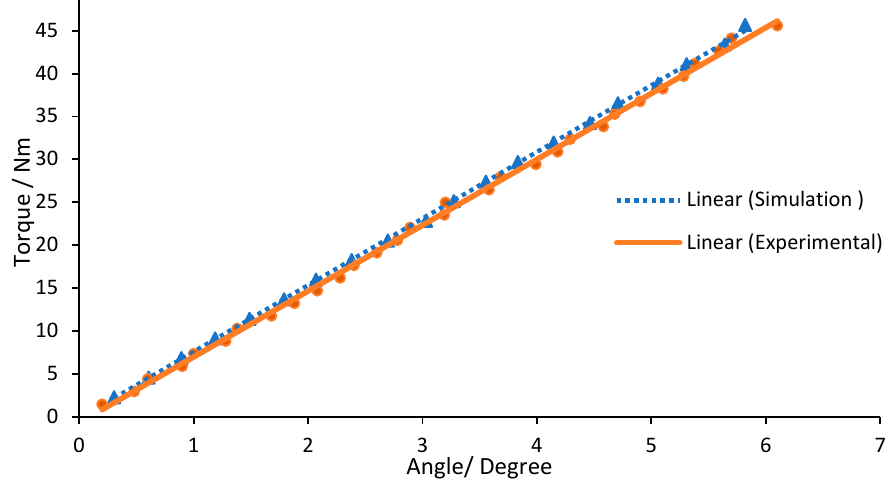
Figure 12. Characteristic of spring stiffness.